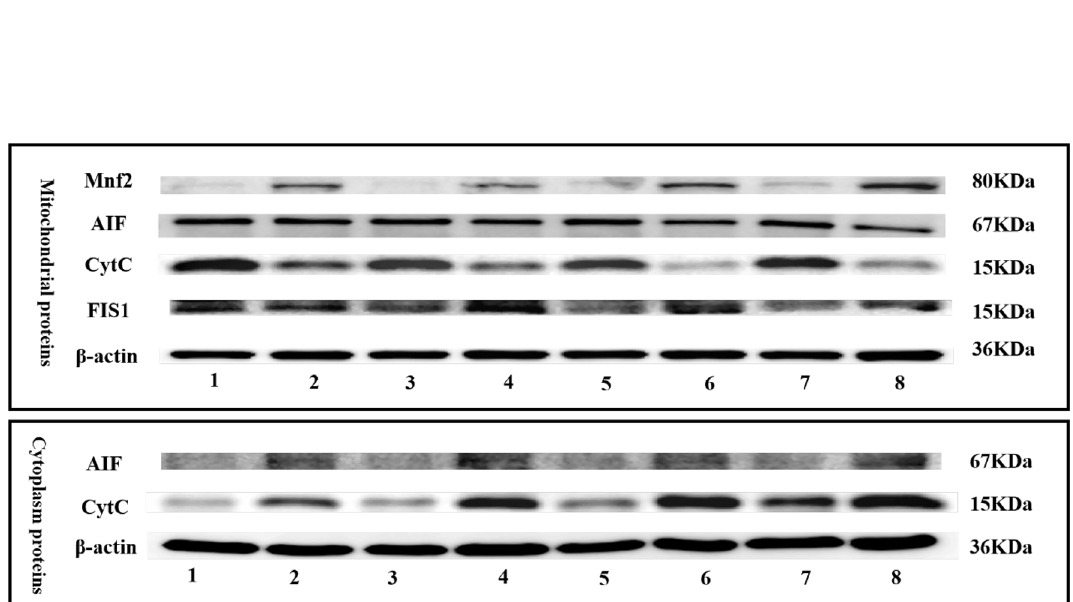
Figure 9. Effects of different treatments on the structure and function of the mitochondria in IPEC-J2. After being treated for 24 h, the expression of Mnf2, FIS1, AIF and CytC (both in the mitochondria and cytoplasm) were determined using the western blot. β-actin served as an internal marker. The different treatments were: 1. Control treatment (T1); 2. SBA treatment (T9); 3. KRT8-siRNA treatment (T2); 4. KRT8-siRNA + SBA treatment (T10); 5. KRT18-siRNA treatment (T3); 6. KRT18-siRNA + SBA treatment (T11); 7. ACTA-siRNA treatment (T4); and 8. ACTA-siRNA + SBA treatment